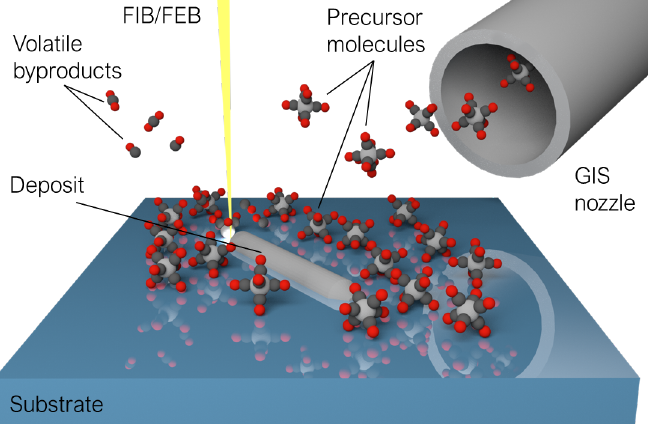
Figure 1. The FIBID/FEBID procedure. The beam is scanned over the surface of the substrate, decomposing the adsorbed precursor molecules on its path. Reprinted from [23], with permissions from IOP Publishing. © IOP Publishing Ltd.